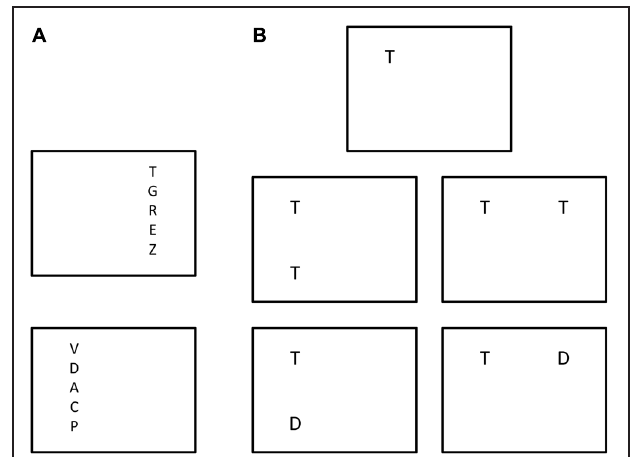
FIGURE 2 | The original version of TVA based assessment devised by Duncan et al. (1999). (A) Different trial types of the whole report experiment. (B) Different trial types of the partial-report experiment with targets (marked as “T”) and distracters (marked as